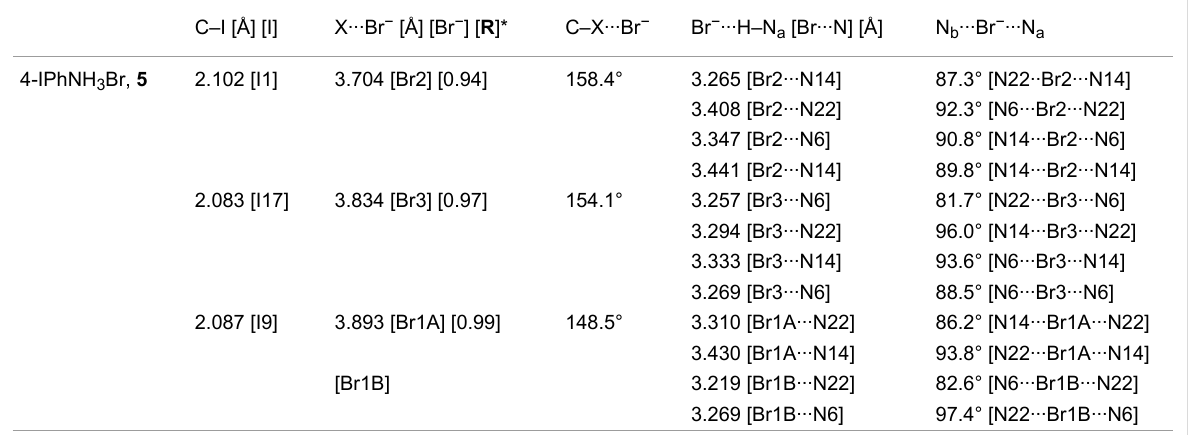
Table 2: Relevant covalent bond, hydrogen bond and halogen bond lengths and angles in 5